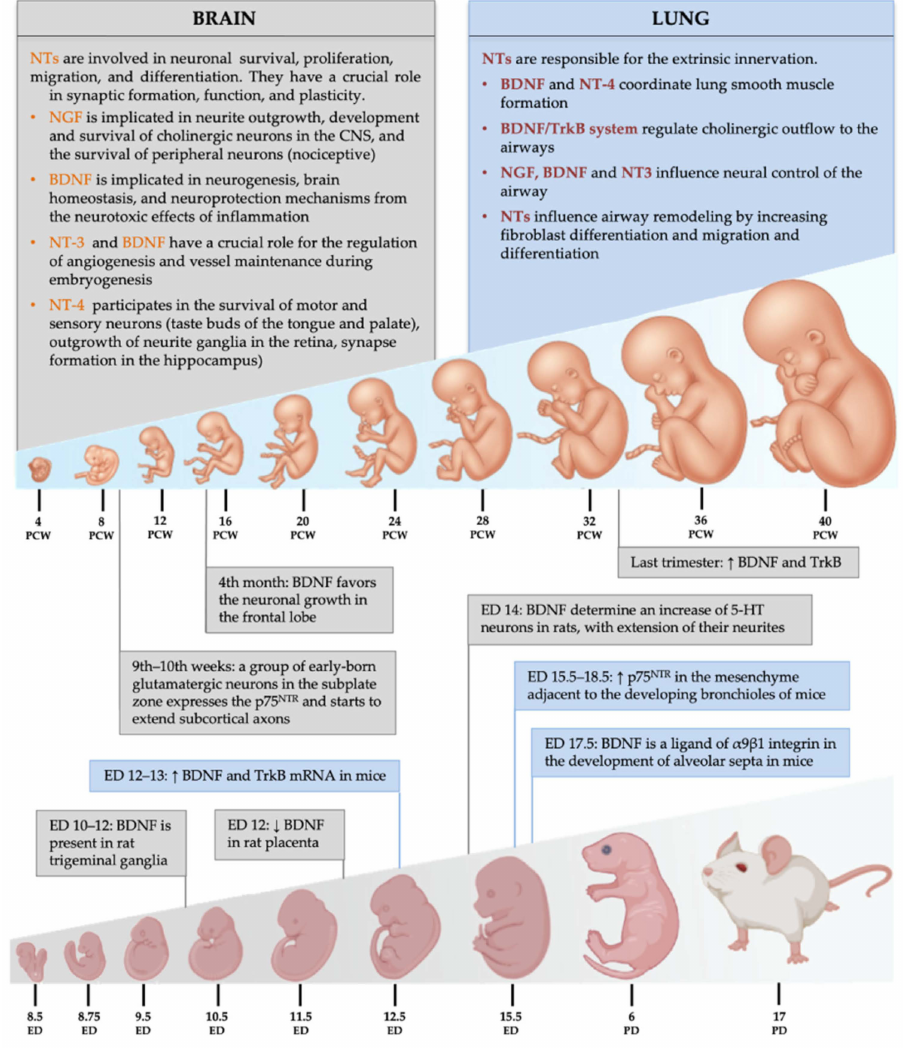
Figure 2. Schematic representation of NTs’ role during pregnancy in humans and rodents. The upper part of the figure shows the role of NTs in the development of the brain and the lungs. In the lower part of the figure, the boxes display the involvement of the NTs at different gestational ages in human and rodent embryos/fetuses. Legend: BDNF = brain-derived neurotrophic factor; ED = embryonic day; NGF = nerve growth factor; NT = neurotrophin; PCW = post-conceptional week; PD = postnatal day; p75 NTR = p75 neurotrophin receptor; Trk = tropomyosin-related kinase; 5-HT = serotonin; ↓